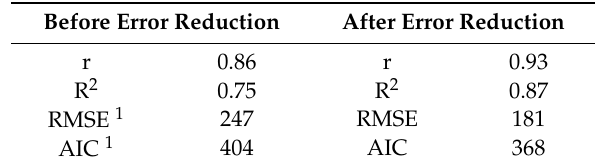
Table 2. The regression parameters before and after error reduction.